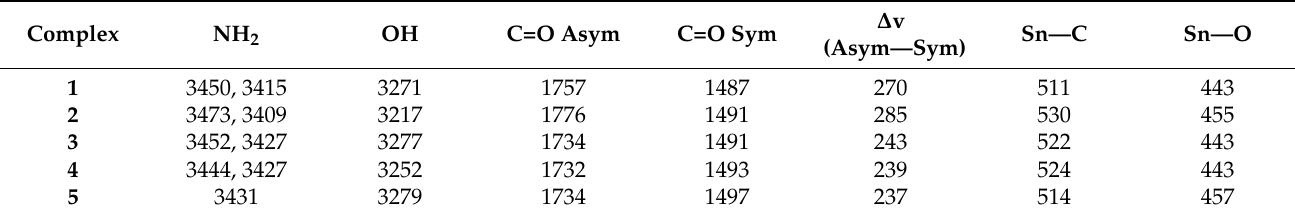
Table 2. Selected FTIR spectral data for 1–5 .